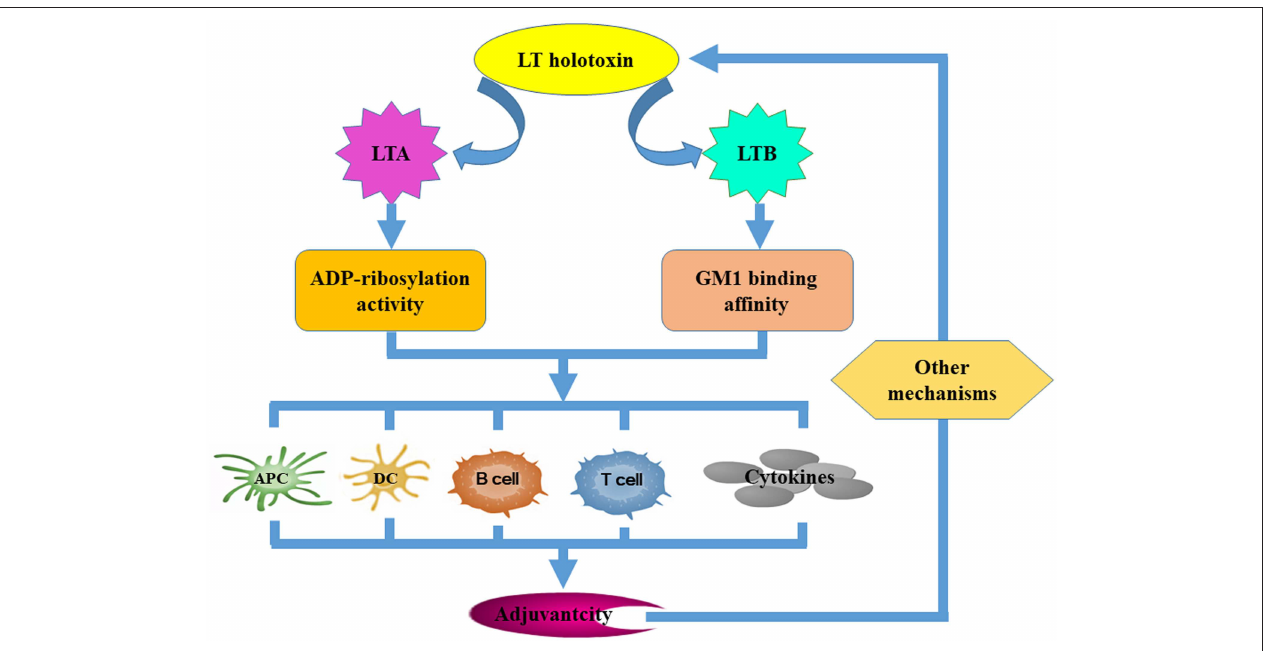
FIGURE 2 | The mechanisms that underpin LT derivative adjuvant activity. Several LT-specific activities facilitate the improvement of vaccine efficacy. Both the ADP-ribosylation activity of the LTA subunit and the GM-binding affinity of the LTB subunit are required for LT to exert its adjuvanticity. Both of these activities contribute to adjuvanticity by improving the antigen-presenting capacity of APCs, promoting DC maturation and activation, activating B and T cells, and inducing cytokine secretion. Other mechanisms independent of the ADP-ribosylation activity of LTA and the GM1-binding affinity of LTB may be